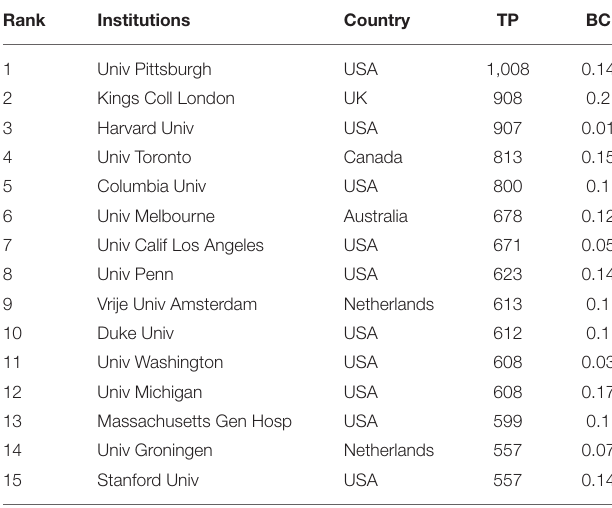
TABLE 5 | The top 15 institutions in network of co-authors’ institutions,